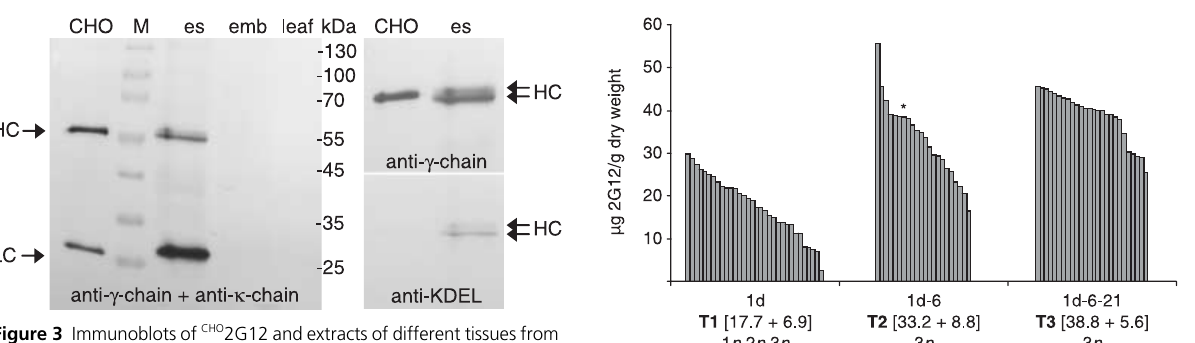
Figure 3 Immunoblots of CHO 2G12 and extracts of different tissues from a Zm 2G12 SEKDEL line (es, endosperm; emb, embryo). The blots were probed with anti- γ -chain, anti- κ -chain and anti-KDEL antibodies as indicated. Heavy (HC) and light (LC) chains are indicated by arrows.